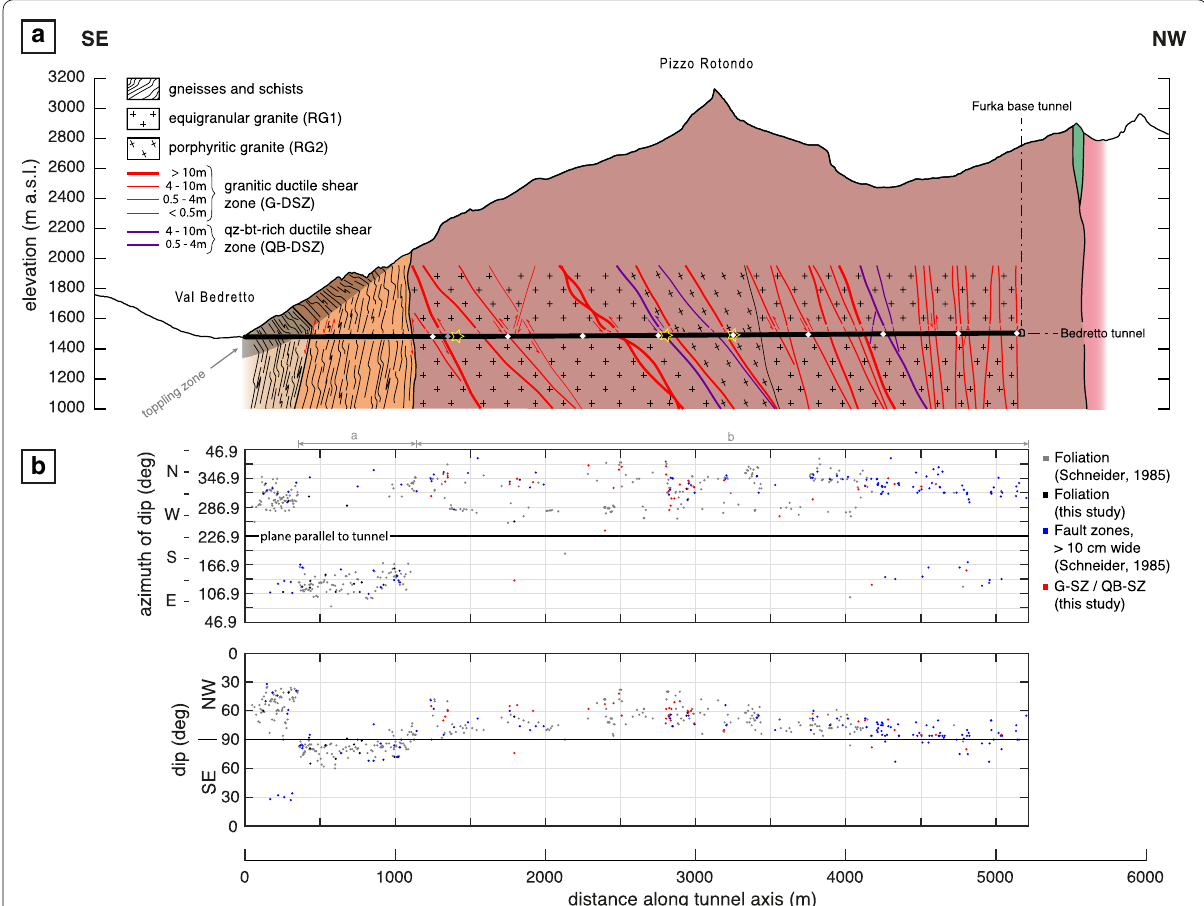
Fig. 3 a Cross-section along the Bedretto tunnel based on the profile of Keller and Schneider (1982), data from the tunnel section of Schneider (1985), and data from this study. Background colors correspond to geological units in the overview map (Fig. 1). White dots indicate origin of Rotondo granite samples used for the analysis of microstructures (Sect. 3.2.4), gray dot indicates sample of a G-SZ used for the analysis of microstructures (Sect. 3.2.4), and yellow stars indicate samples used for investigations based on zircons (Sect. 4). The cross-section is simplified in order to highlight the most important structural features. Note the general upward movement of the northern block as well as the increasing occurrence and increasing steepness of the shear zones in the Rotondo granite towards NW. b Dip direction (upper plot) and corresponding dip (lower plot) of the foliation, brittle fault zones, and ductile shear zones as a function of distance along Bedretto tunnel. The arrows on the top of the figure mark sectors considered in the sub-figures of Fig.